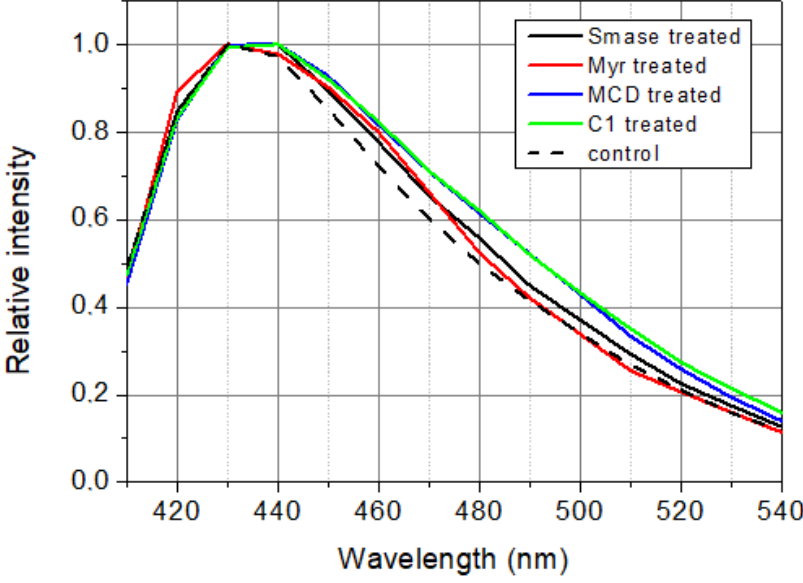
Figure 6. Calculated steady-state spectra of LAURDAN. λ ex = 369 nm.